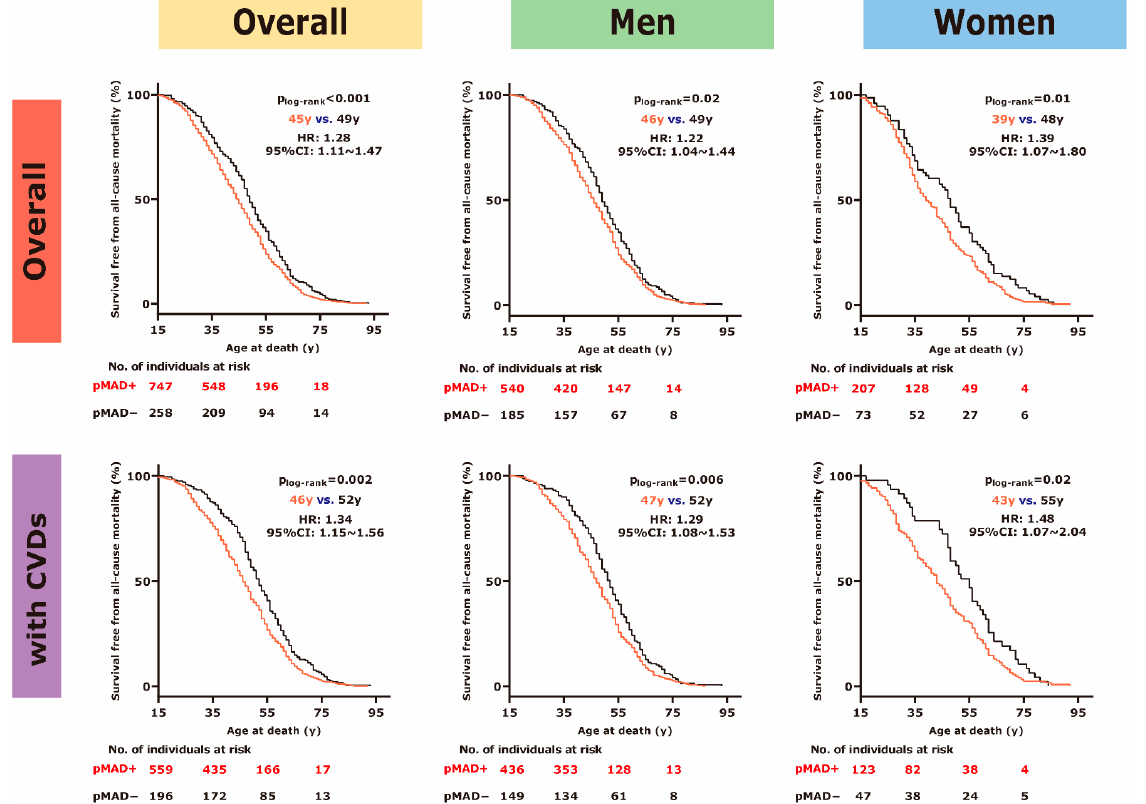
Figure 2. Among 1026 cases of disease-dominant death (21 cases without information of age at death), pMAD+ (red curves) showed poor survival than pMAD − (black curves) with a significant hazard ratio (HR) of all-cause mortality of 1.28 (95% confidence interval [CI]: 1.11~1.47, p < 0.001; upper row), which was increased to 1.34 (95% CI: 1.15~1.56, p = 0.002) in those with both pMAD and CVDs (lower row; nine cases without information of age at death). CVDs = cardiovascular diseases. pMAD = posterior